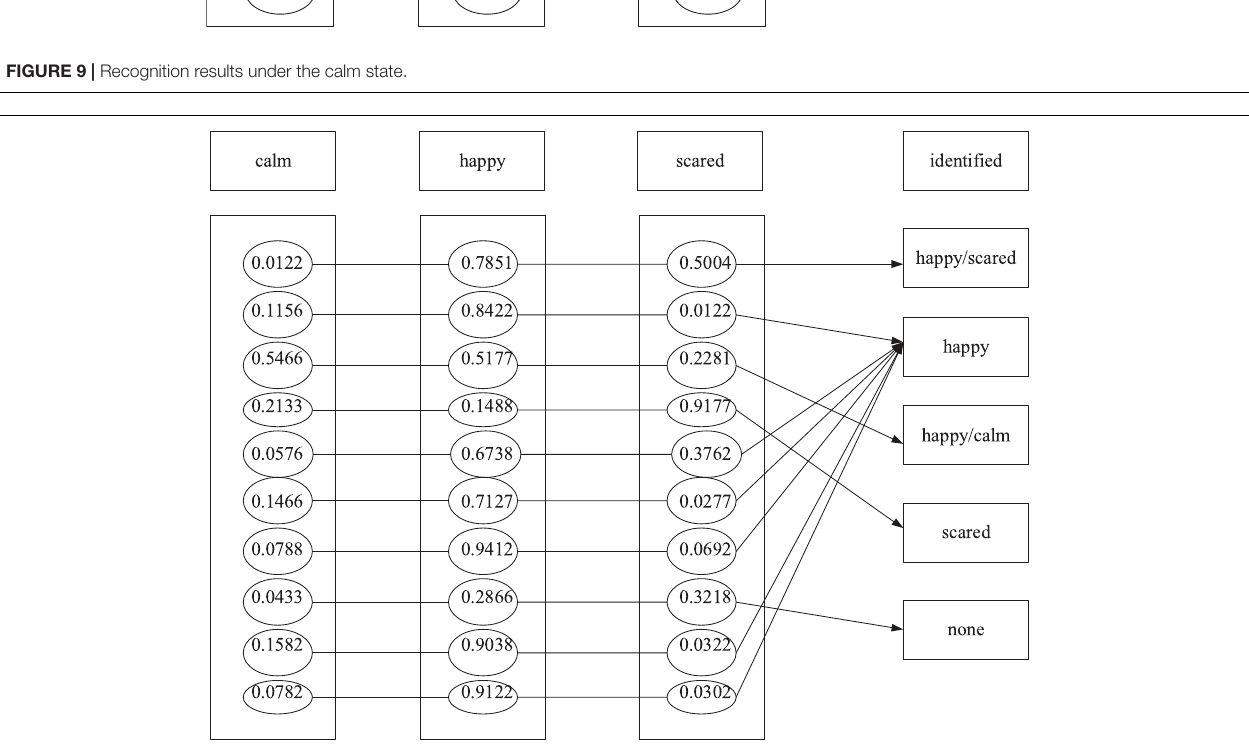
FIGURE 10 | Recognition results under the happy